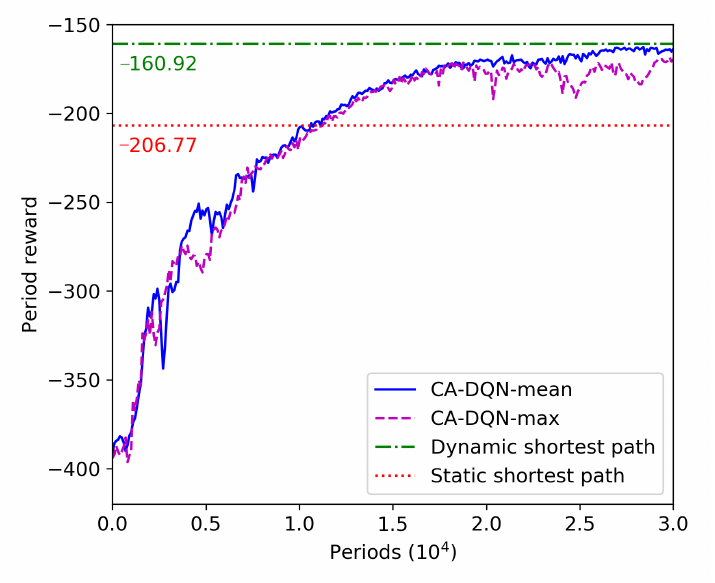
Figure 5. Training curve of the